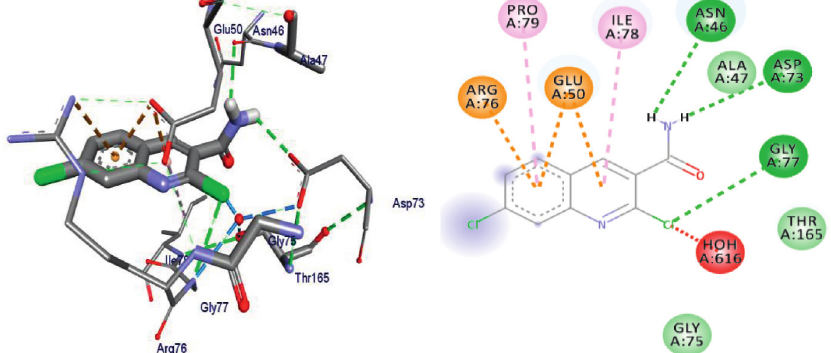
Figure 4: The binding interactions of compound 6 against E. coli DNA gyrase B (PDB ID :6F86).